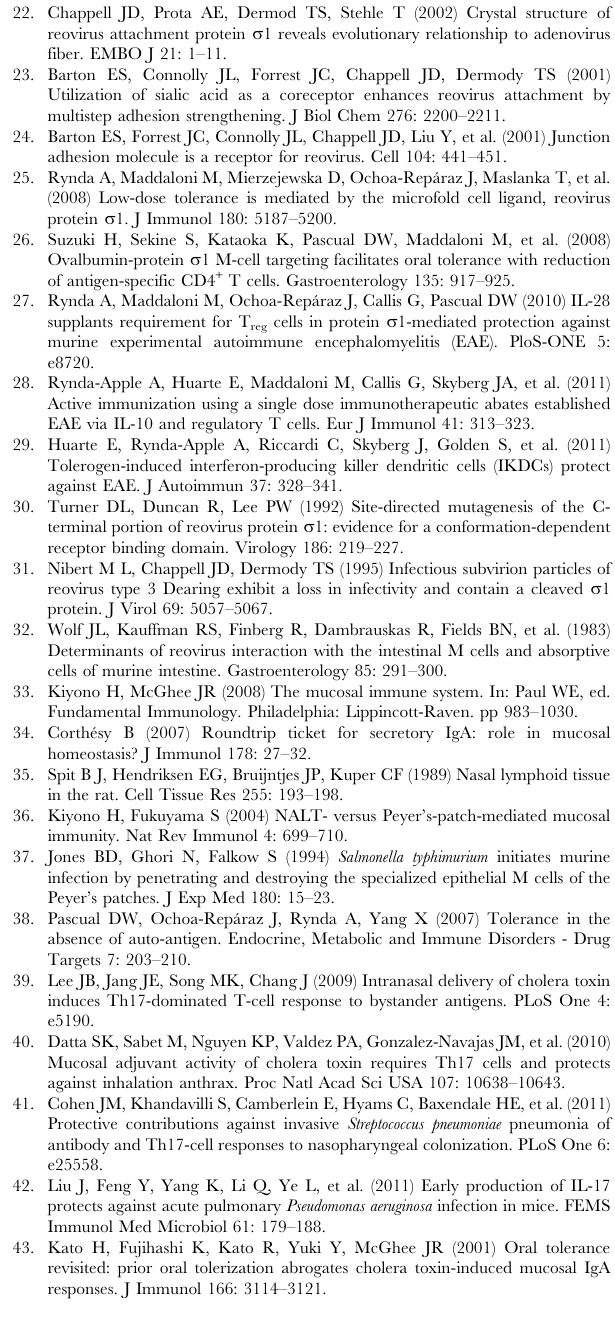
Figure S2 IgG subclass anti-OVA responses by mice immunized with OVA plus CT. The OVA plus CT- immunized mice in Figure S1 were evaluated for their A. IgG1, B. IgG2a, and C. IgG2b subclass responses to OVA on days 21 and 28 post-primary vaccination as mean 6 SEM. There were no statistical differences between immunization groups measured at day 21 or 28.